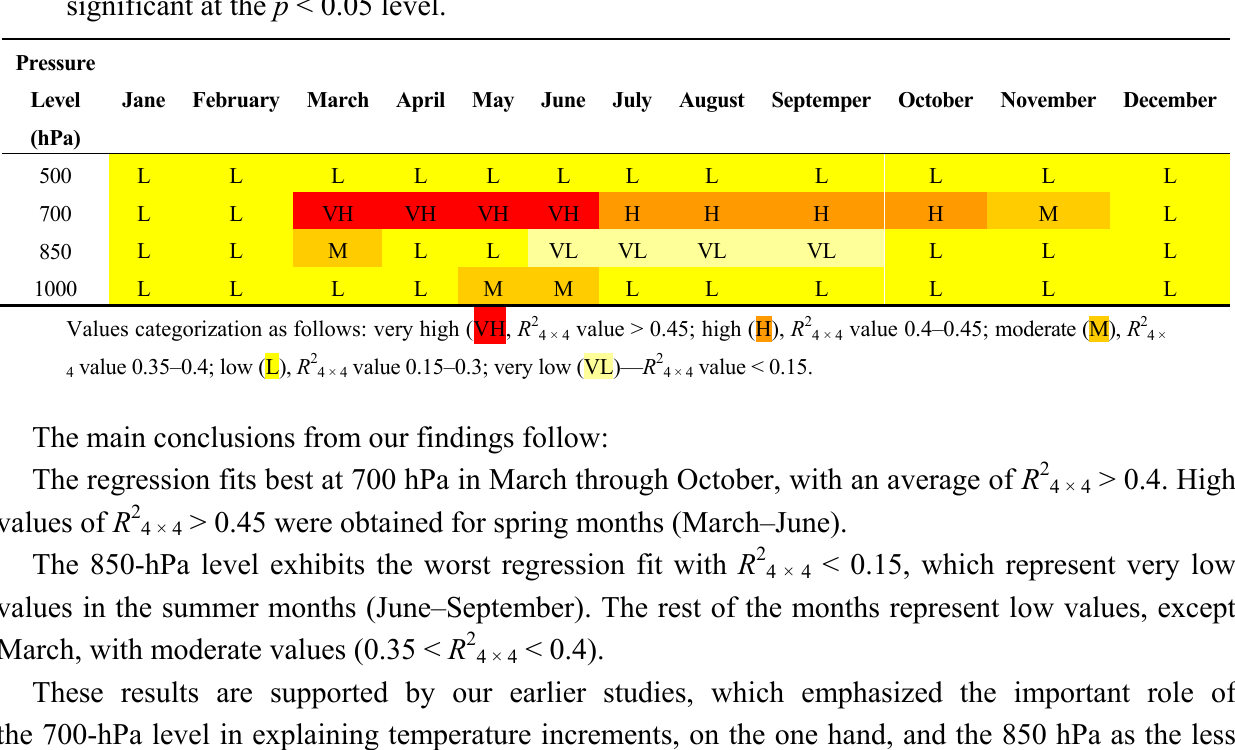
Table 4. Annual categorization of R 2 values for the 4° by 4°-cell regression run, at the different pressure levels. Each cell consists of 81 grid points ( N = 81), and values are significant at the p < 0.05 level.